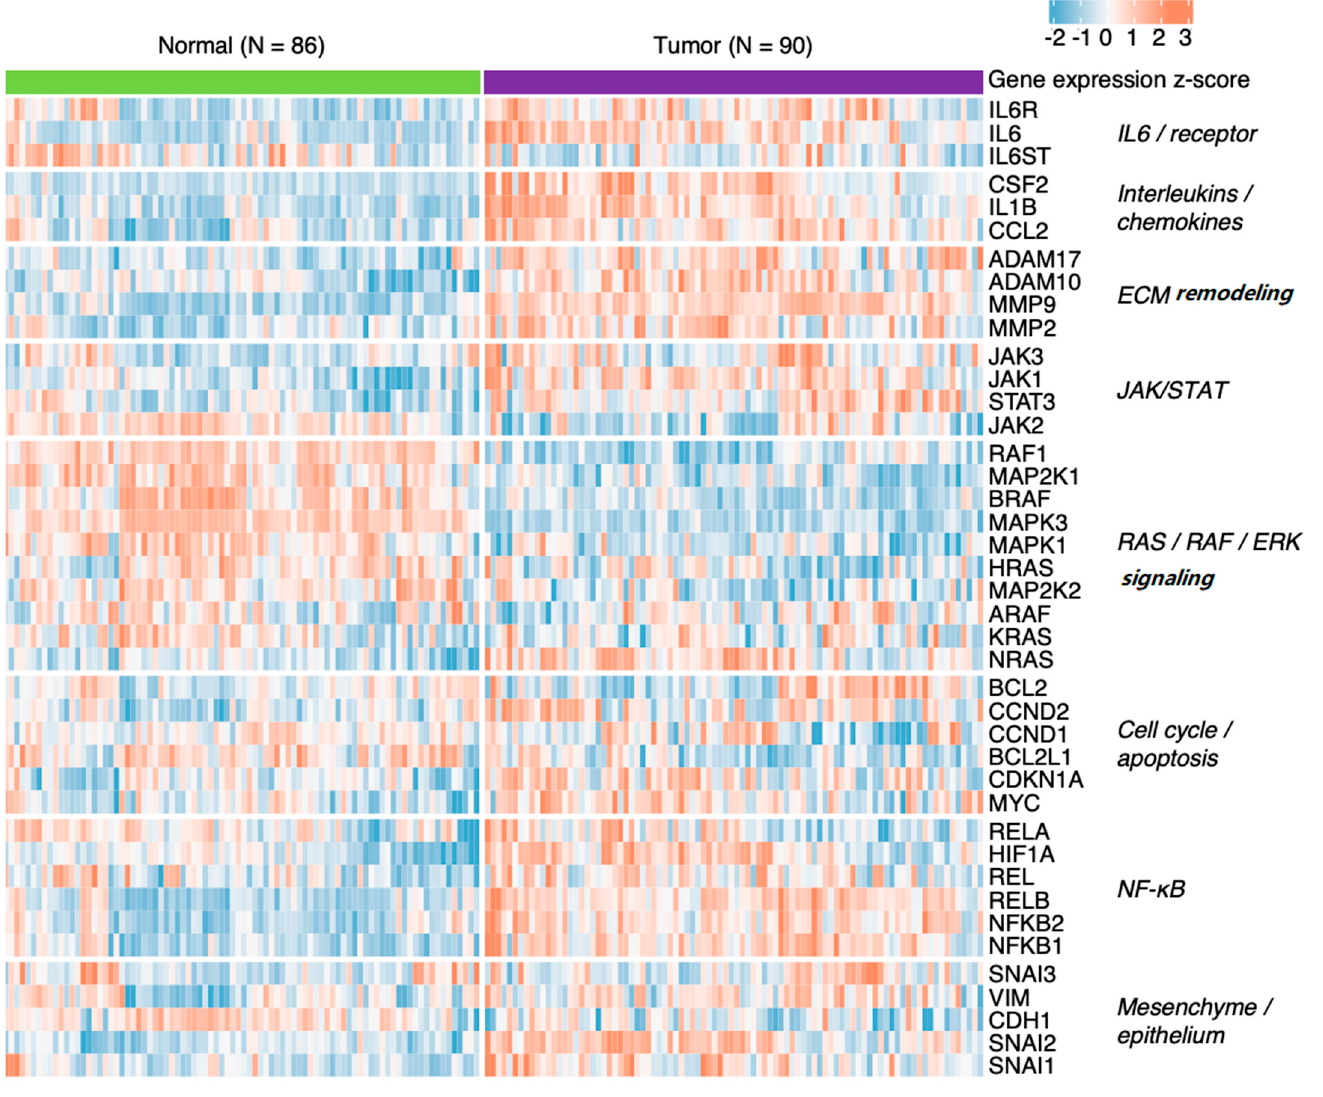
Figure 6. Deregulation of IL-6 signalling and its downstream targets in HNSCC tumours compared to matched samples of adjacent healthy mucosa. (see Novotný et al., 2020 [141] for